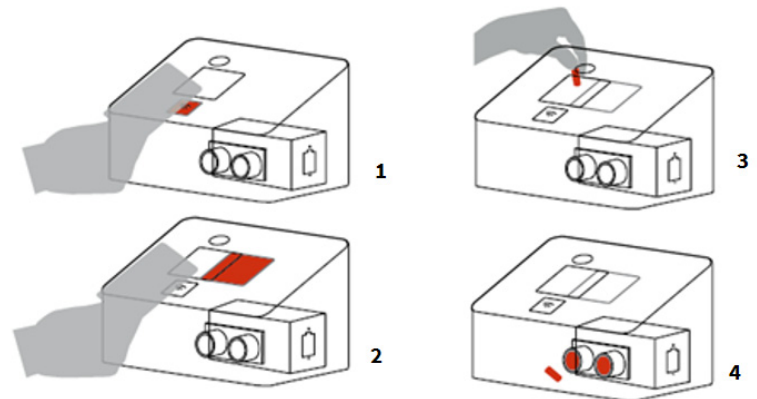
Figure 9. Electronics and bucket mechanics: ( 1 ). The user swipes the card; ( 2 ). After the card has been recognized, the top door slides open; ( 3 ). The user inserts the cigarette butts. ( 4 ). The machine counts how many cigarette butts are introduced through an optical system.